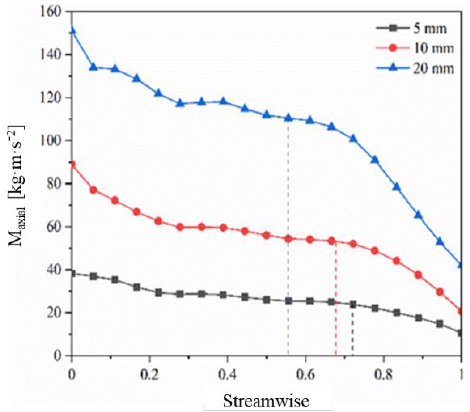
Figure 7. Axial momentum of leakage flow.